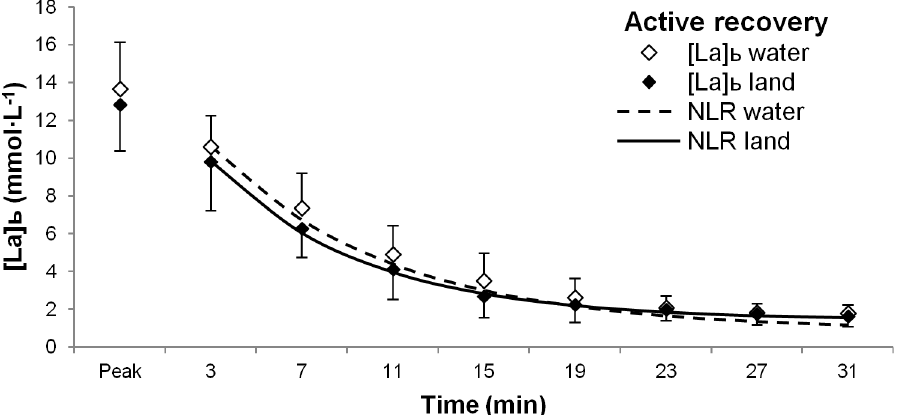
Fig 1. Blood lactate removal during active recovery. Blood lactate concentration decays duringwater- based(white diamonds) and land-based (black diamonds) active recovery conditionsfollowinga 30-second all-out bout of cycling. Non-linearregressioncurves are also shown for water-based (dashedline) and land- based(solid line) recovery. Abbreviations: [La] b , blood lactate concentration; NLR, non-linearregression.